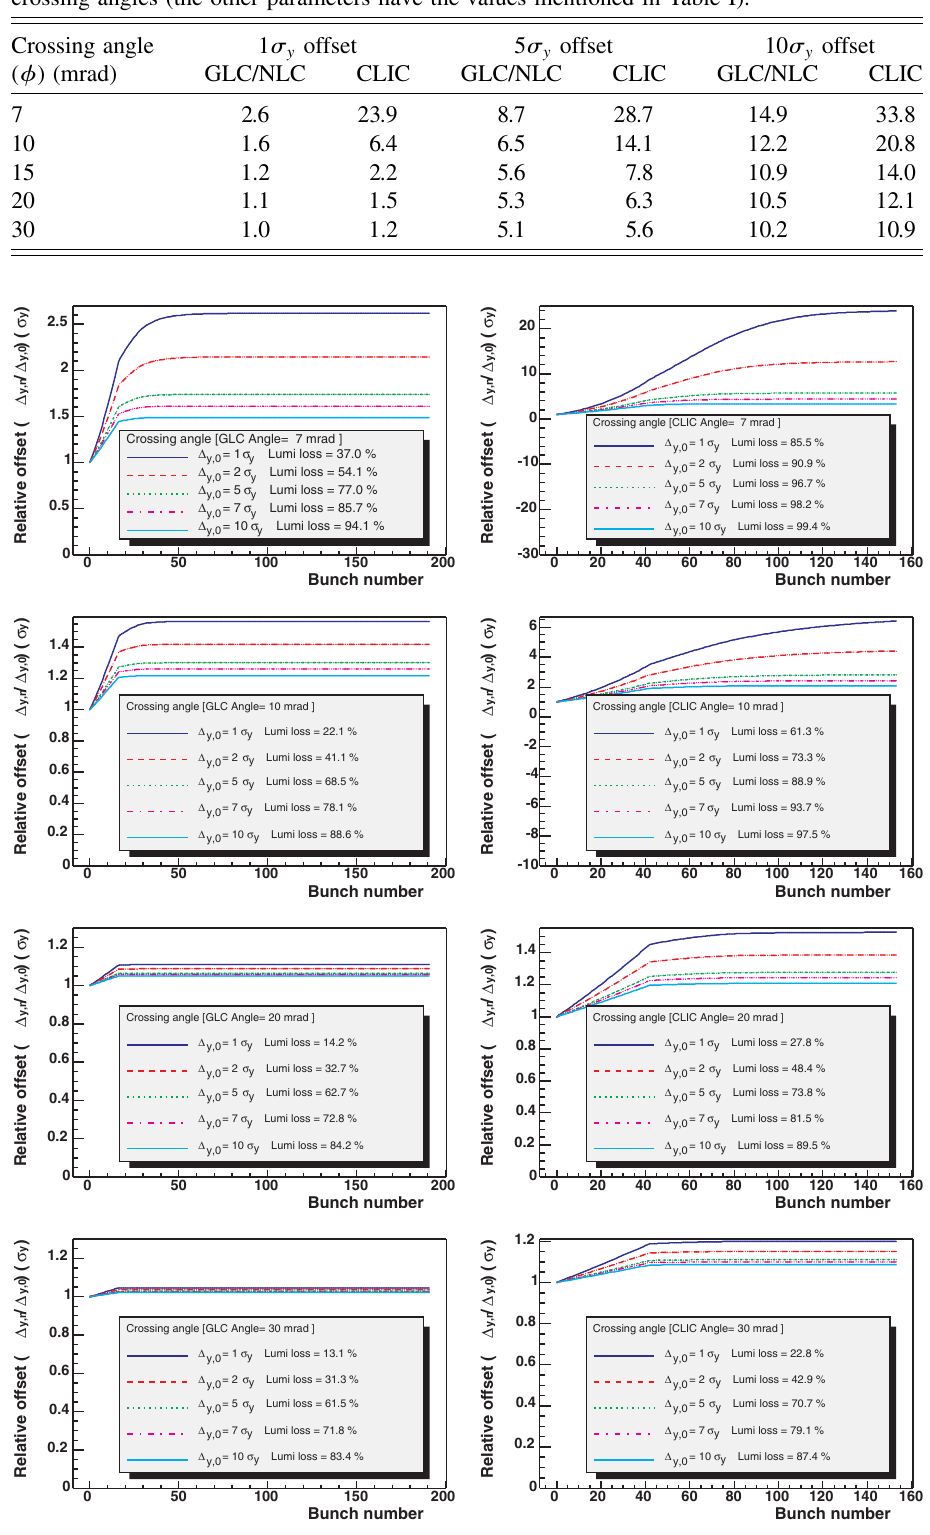
FIG. 4. (Color) Normalized beam blowup as a function of the bunch number for a crossing angle of (from top to bottom) 7, 10, 20, and 30 mrad for different values of the initial beam offset. The normalization is done by dividing the actual offset of a given bunch by the initial beam